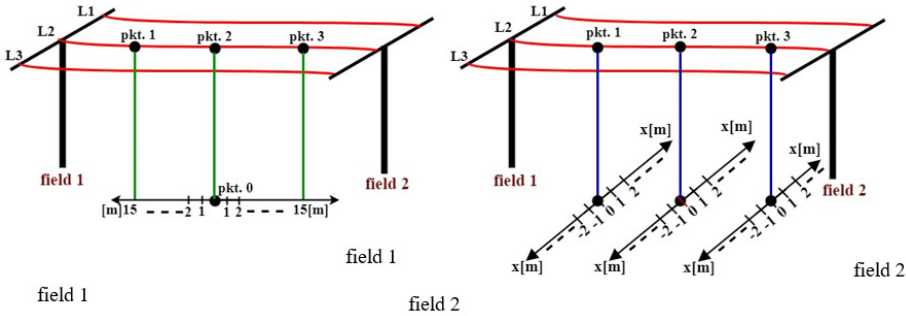
Figure 2. Diagram of a test stand for measuring electromagnetic field components along the line’s phase conductors, and across the medium-voltage power line.